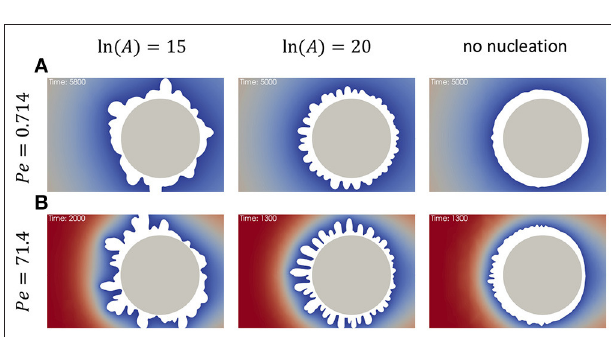
FIGURE 5 | Effect of nucleation rate on the precipitation on a particle in reactive flow at Da II = 0.34. (A) Pe = 0.714, (B) Pe = 71.4. The snapshots in the left column correspond to nucleation rate prefactor ln( A ) = 15, in the middle column ln( A ) = 20, and in the right column the nucleation is “off” (all surface is reactive from the